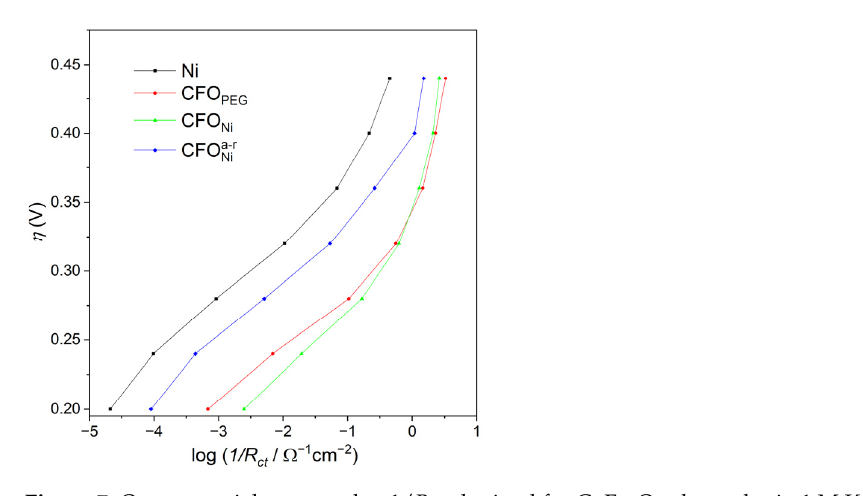
Figure 7. Overpotential η versus log 1/ R ct obtained for CoFe 2 O 4 electrodes in 1 M KOH during the oxygen evolution process.